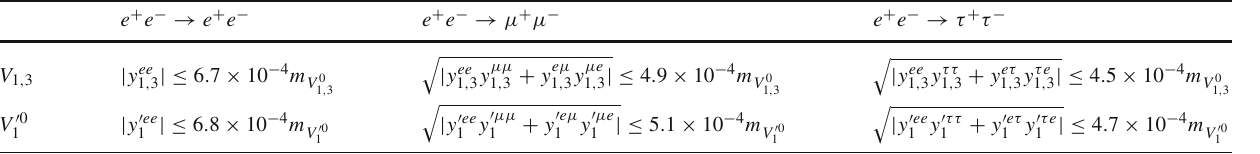
Table 2 LEP limits on couplings for masses well above the center of √ s ∼ 130 − 207 GeV. To make them valid for any masses, mass energy one should replace the masses by ( s cos θ/ 2 + m 2 ) 1 / 2 by averaging over